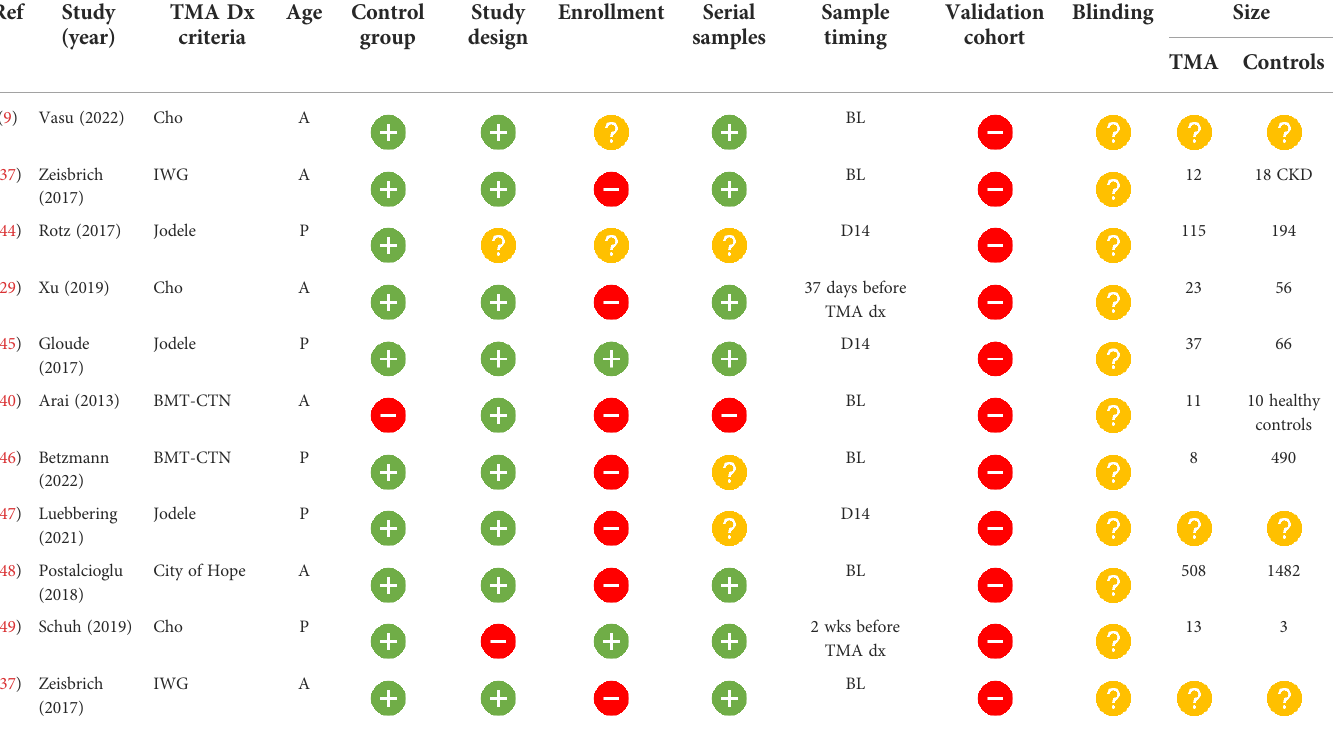
TABLE 4 b -group risk